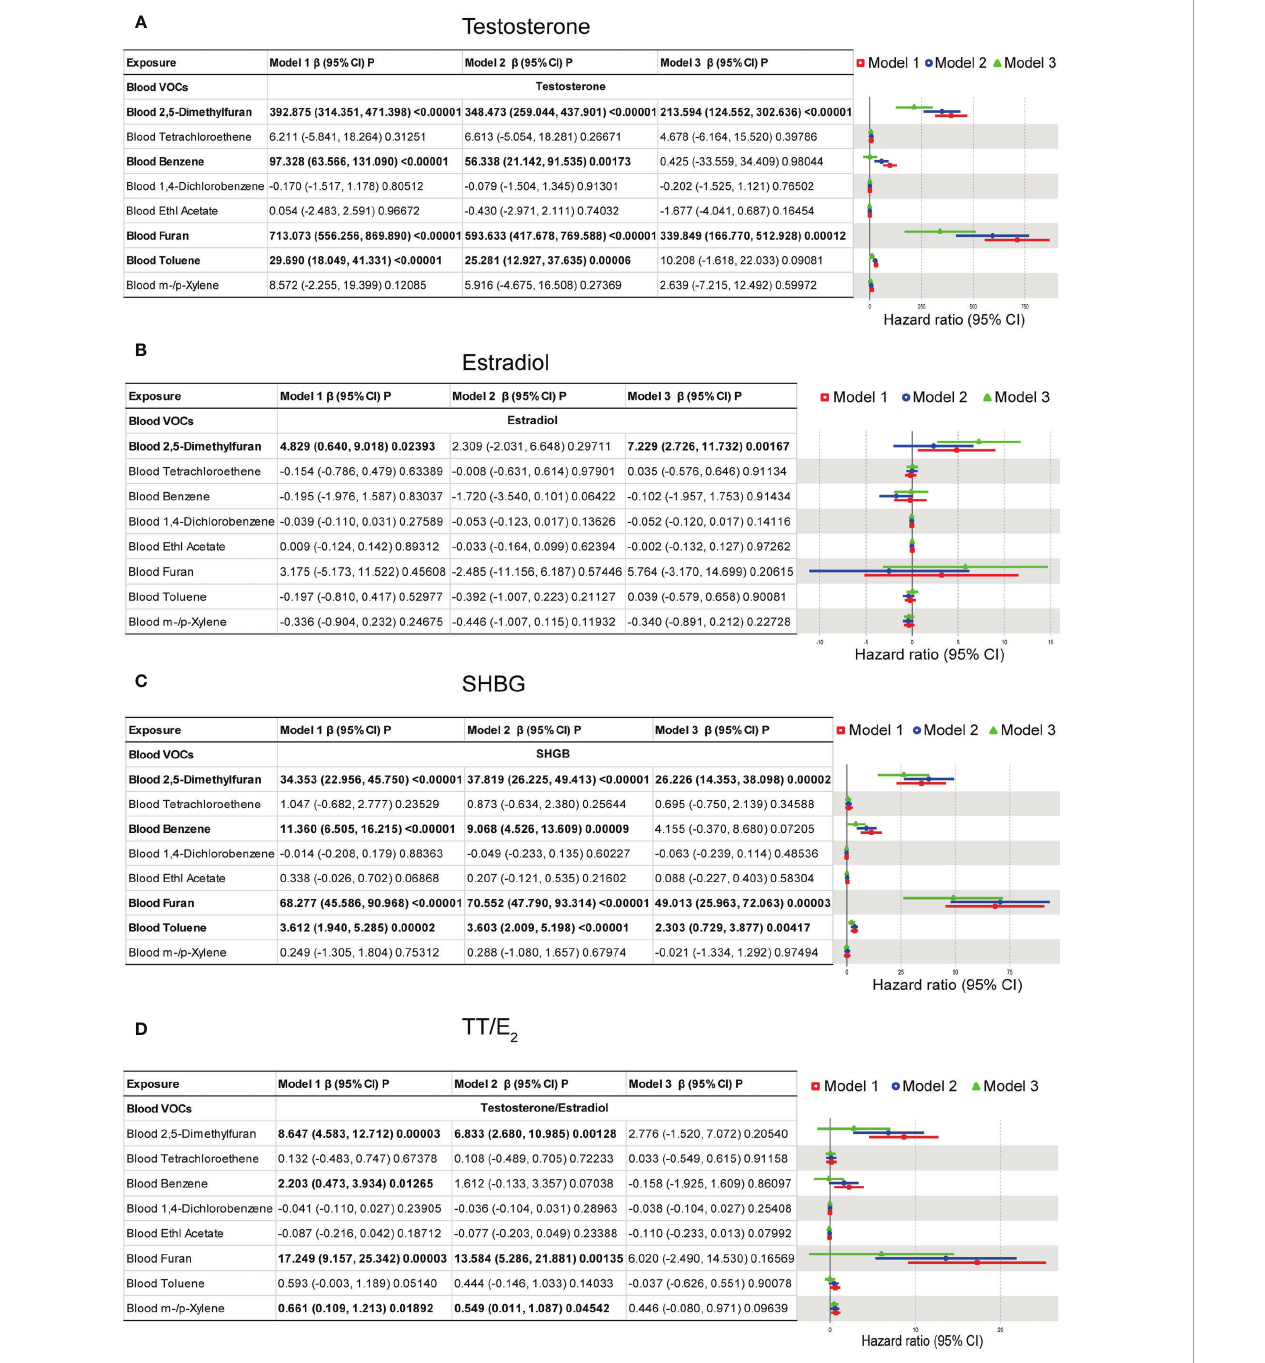
FIGURE 5 Multivariate weighted linear model analysis between VOCs and sex hormones. (A) Models of blood VOCs and male testosterone. (B) Models of blood VOCs and male estradiol. (C) Models of blood VOCs and male SHBG. (D) Models of blood VOCs and male TT/E2. Model 1: adjusts for none. Model 2: Minimally adjusted model which adjusts for age, race/ethnicity, education level, poverty income ratio, and marital status. Model 3: Fully adjusted model which adjusts for age, race, education, marital status, body mass index (kg/m2), family income to poverty ratio, smoking and